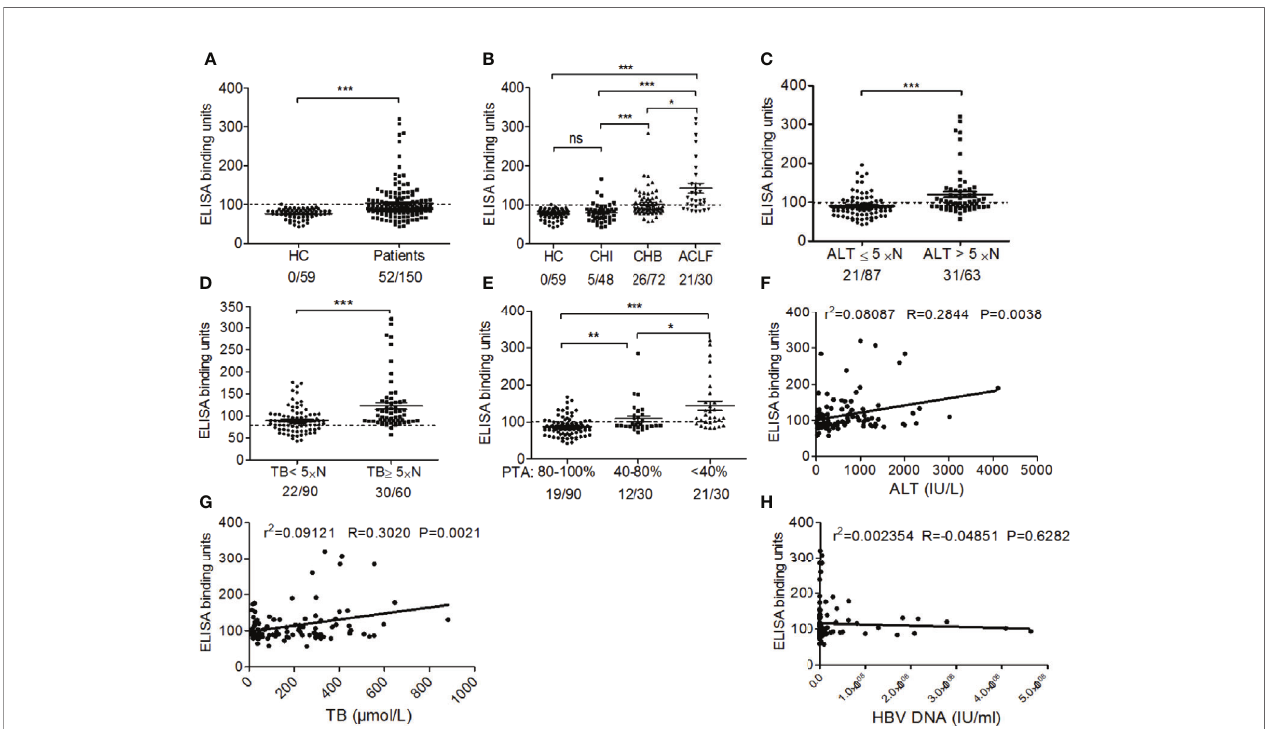
FIGURE 3 | The association of prevalence and titres of anti-EBP-1 autoantibodies with clinical features of patients with CHB. (A) The scatter plot showing the comparison of ELISA results of serum anti-EBP-1 autoantibodies in total patients with chronic HBV infection (n=150) versus HC(n=59); Signi fi cance was determined by Mann Whitney test. (B) Comparison of the prevalence and titres of serum anti-EBP-1 autoantibodies in HCs (n = 59) and patients with CHI (n = 48), CHB (n = 72) or ACLF (n = 30); X/X = the number of EBP-1 autoantibody-positive patients/the total number of patients in each group. HC: healthy control; CHI: eAg +/- chronic HBV infection; CHB: eAg +/- chronic hepatitis B; ACLF: HBV-associated acute-on-chronic liver failure. Signi fi cance was determined by Kruskal-Wallis test followed by Dunn ’ s Multiple Comparison Test. Comparison of the prevalence and titres of serum anti-EBP-1 autoantibodies in patients with (C) low ( ≤ 5 × normal value; 21/ 87) and high (> 5× normal value; 31/63) ALT levels, (D) low (< 5 × normal value; 18/90) and high ( ≥ 5 × normal value; 30/60) TB levels (Mann Whitney test), (E) low (< 40%; 21/30), moderate (40 – 80%; 12/30), and high (80 – 100%; 19/90) PTA (Kruskal-Wallis test followed by Dunn ’ s Multiple Comparison Test). The dotted line at 100 binding units represents the cut-off value. The scatter plot showing the correlation between serum anti-EBP-1 autoantibody levels and (F) ALT, (G) TB, or (H) HBV DNA levels. ALT, alanine aminotransferase; TB, total bilirubin; PTA, prothrombin activity; ns, non-signi fi cant; * P < 0.05; ** P < 0.01; *** P <